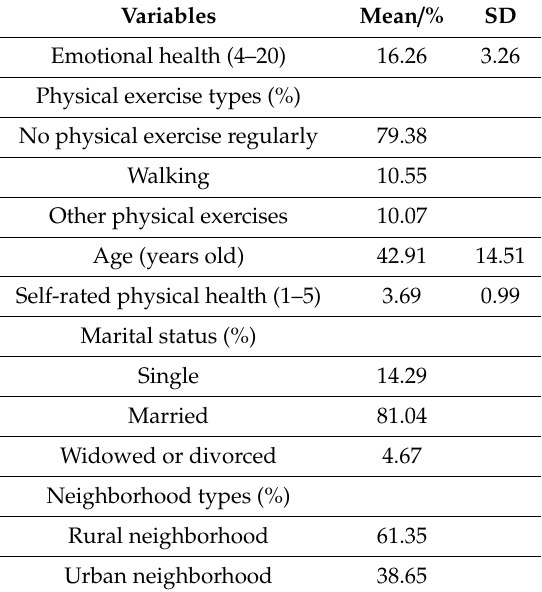
Table 1. Summary statistics of study